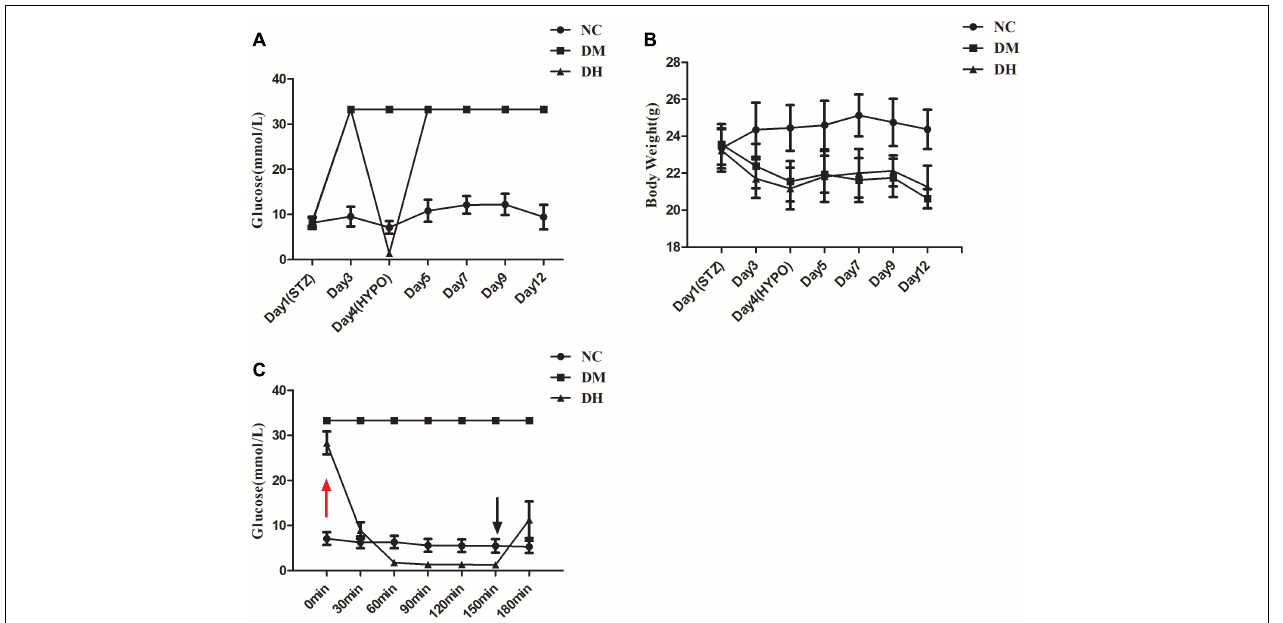
FIGURE 2 | Blood glucose and body weight data. (A) Glycemia levels of the three groups. (B) Body weight trajectory of the three groups. (C) Glucose levels of the three groups during the severe hypoglycemia episode ( < 2.0 mmol/L). NC, normal control; DM, type 1 diabetes mellitus; DH, severe hypoglycemia. Data are the means ±